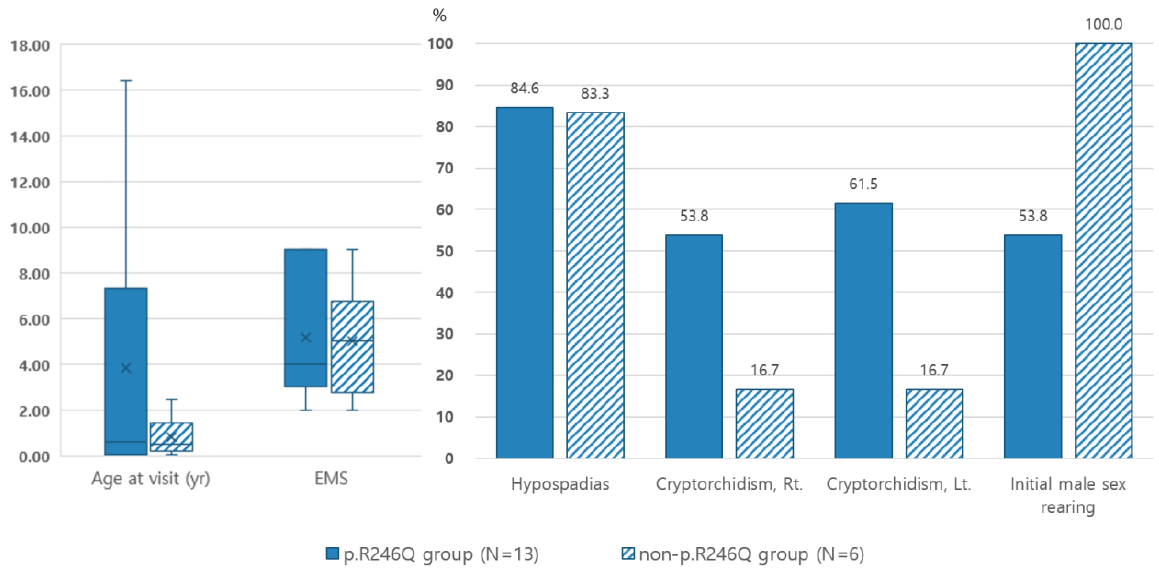
Figure 2. Clinical manifestations of 19 patients with or without the p.R246Q allele. × and horizontal line represented the mean and median values, respectively.